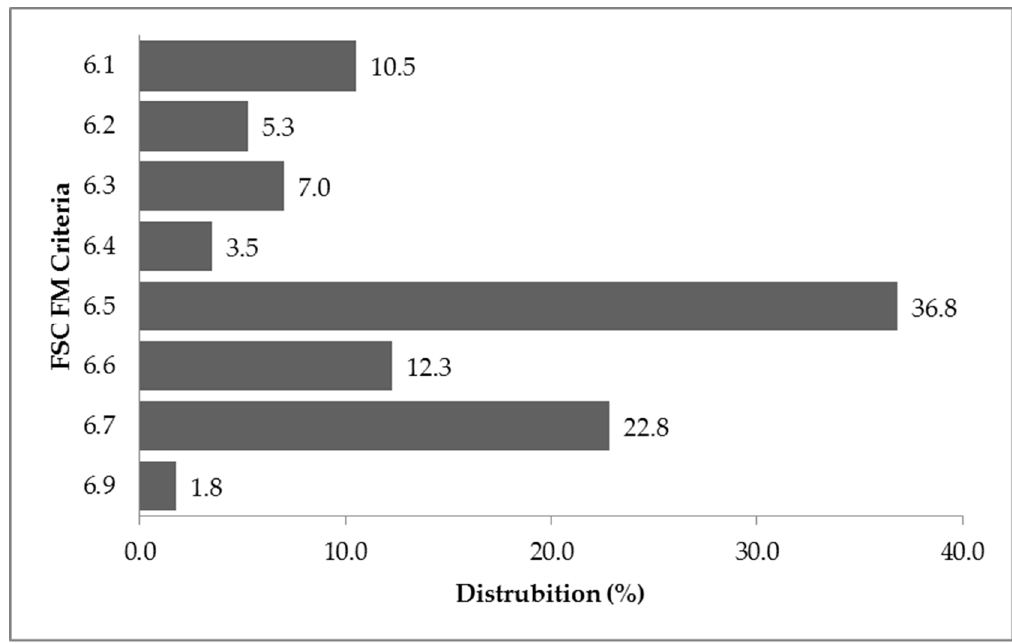
Figure 3. The distribution of criteria related to Principle 6.